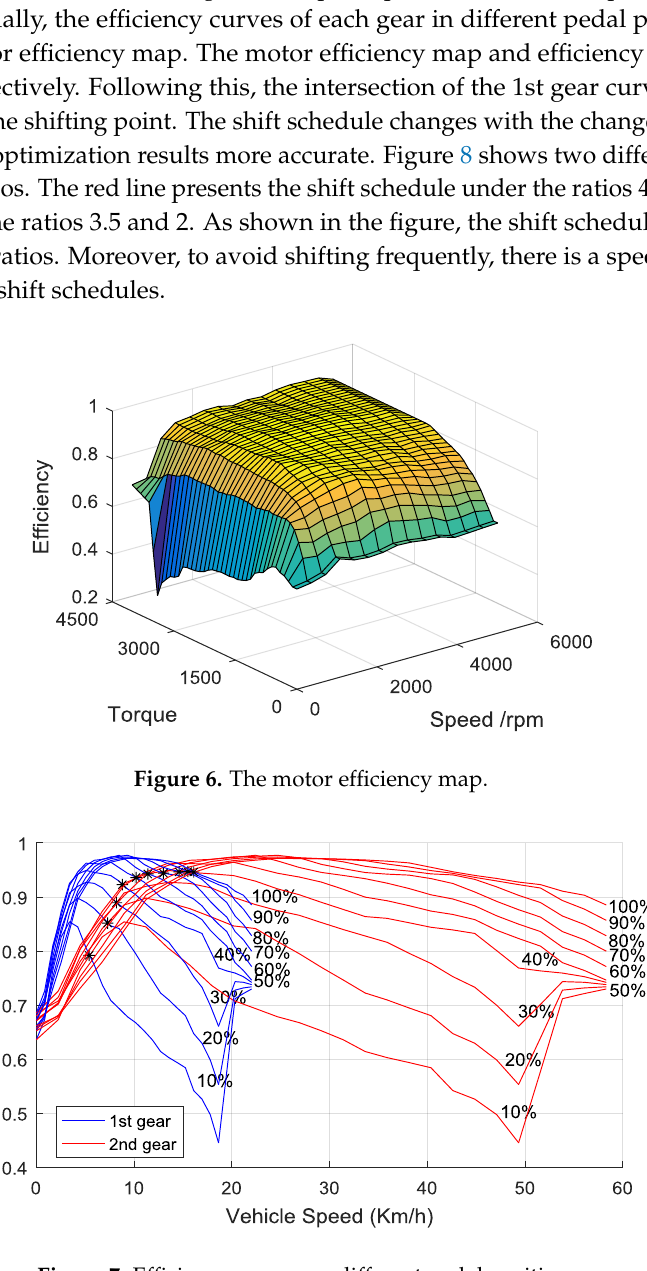
Figure 8. Shift schedules under different gear ratios. 3.2. Gear Ratio Optimization There are many algorithms for gear ratio optimization. Additionally, the common method is the enumeration algorithm, in which the global optimization result can be ensured. However, the accuracy of enumeration is limited to the step length and computing capability. In this paper, a gear ratio optimization algorithm is put forward based on the improved particle swarm optimization algorithm (PSO). The PSO algorithm is a kind of swarm intelligence optimization algorithm, in which the random particles generated by the initialization are iterated to search for the optimal solution. In each iteration, the particle location is updated by tracking the current local optimum and the global optimal solution. Additionally, the termination condition is generally set to achieve the maximum cycle number or to meet the minimum error condition [28,29]. To prevent the PSO algorithm from falling into the local optimal solution, a random variation factor is introduced to the algorithm. If it meets the trigger condition, the particle location generates a random offset. The flow of the PSO algorithm can be described in the following steps: Step 1 (Initialization): Set the time counter 0 t 